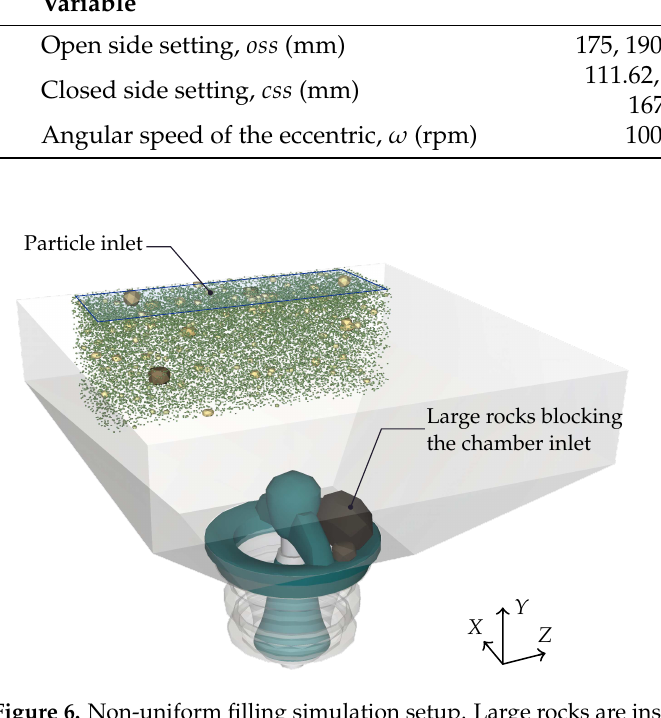
Figure 6. Non-uniform filling simulation setup. Large rocks are inserted covering a feed inlet, and one side of the chamber is